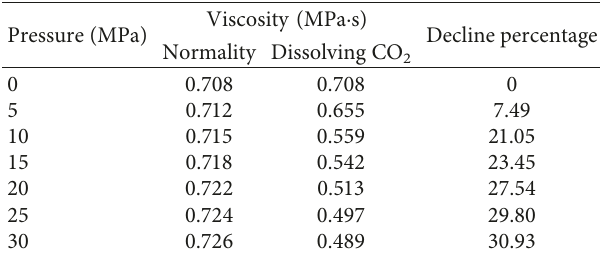
Figure 2: Curve of solubility versus pressure. Table 4: Oil